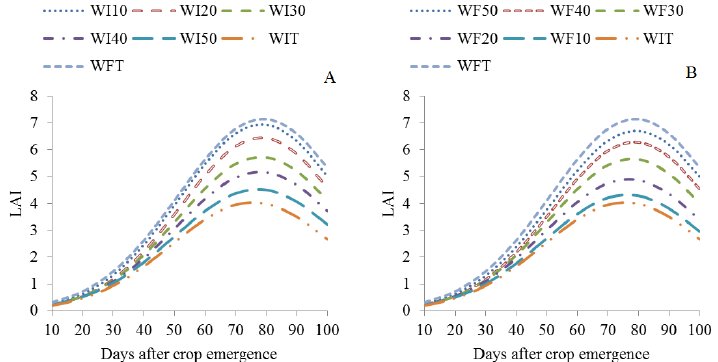
Fig. 2. Dry bean leaf area index (LAI) trend over time at different treatments of weed interference (A) and weed free (B) periods. WI10, WI20, WI30, WI40 and WI50: weed infested periods until 10, 20, 30, 40 and 50 days after crop emergence, respectively; WF10, WF20, WF30, WF40 and WF50: weed free periods until 10, 20, 30, 40 and 50 days after crop emergence, respectively; WIT